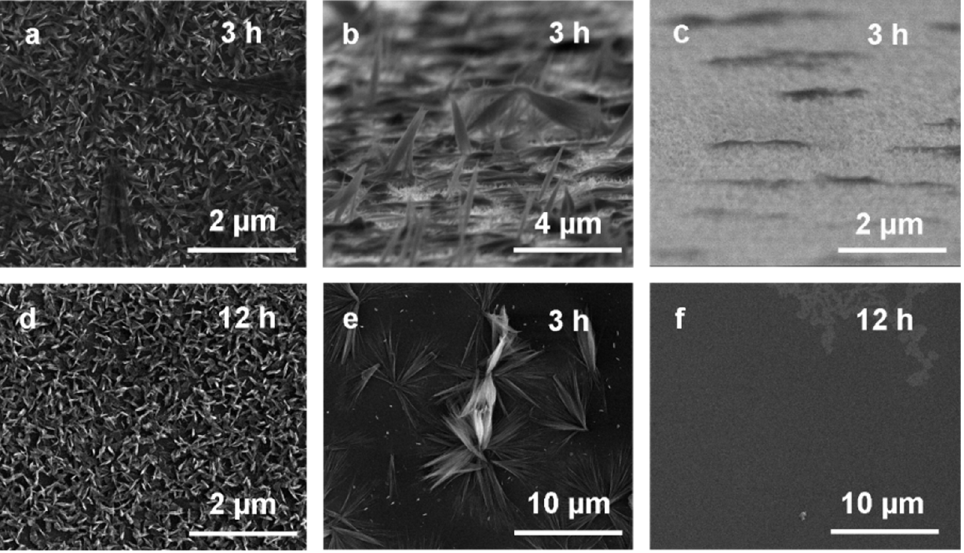
Figure 5. SEM images of copper surfaces immersed in 0.033 M ammonia solution: ( a – c ) for 3 h, ( d ) for 12 h. SEM images of copper surfaces immersed in 0.066 M ammonia solution: ( e ) for 3 h, ( f ) for 12 h.